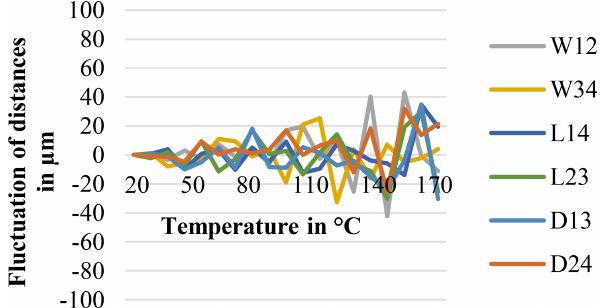
Figure 13. Fluctuation of determined distances of the reference pipes during preheating.